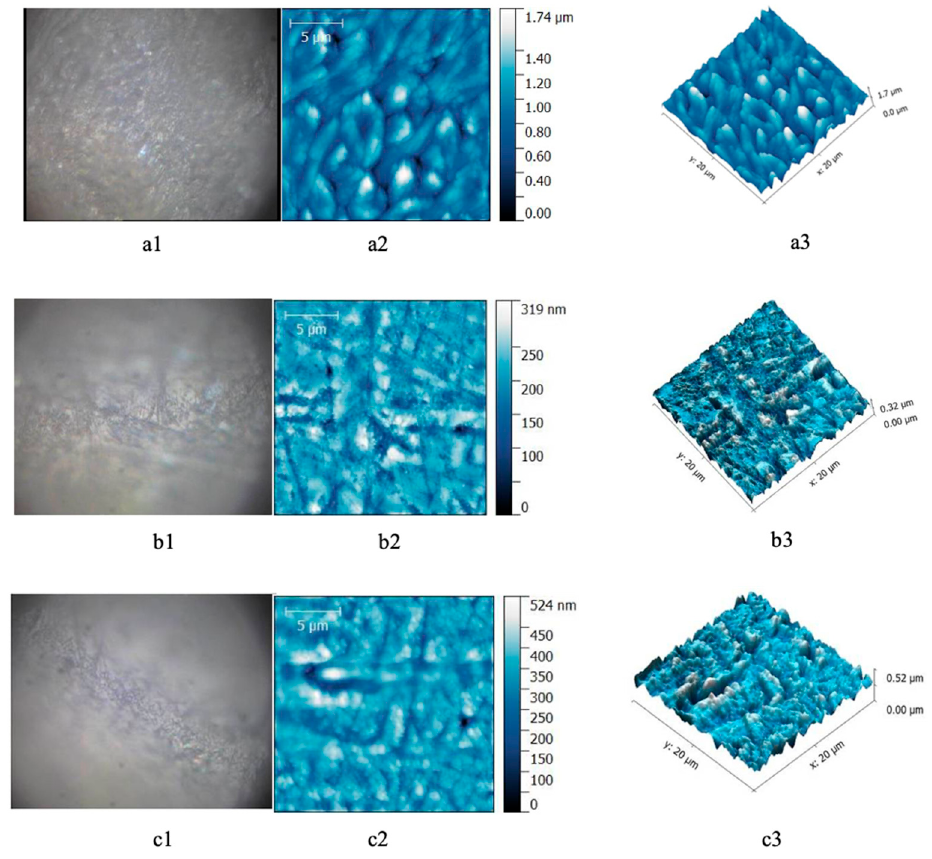
Figure 1. Enamel samples form healthy patients. ( a ) Before bleaching; ( b ) after 16% gel bleaching; ( c ) after 40% gel bleaching. ( a1 , b1 , c1 ) Optical image; ( a2 , b2 , c2 ) AFM bidimensional image; ( a3 , b3 , c3 ) AFM tridimensional image. Scanning parameters: scanned area—20 × 20 μ m 2 , 556 × 556 pts, scan frequency—1 Hz, FB 1, scan speed—97.85 μ m/s.